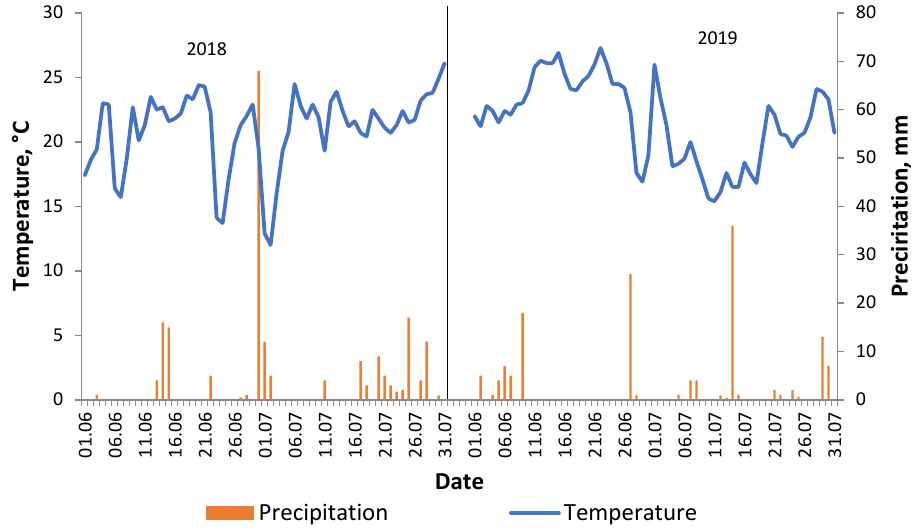
Figure 1. The weather conditions in June–July in the Kyiv region (2018–2019). In 2019, the level of humidity in this period in the Kyiv region was lower—HTC = 1.2 for June–July. Under the conditions of the Chernihiv region, a dry June (HTC = 0.3) and rather wet July (HTC = 1.13) were